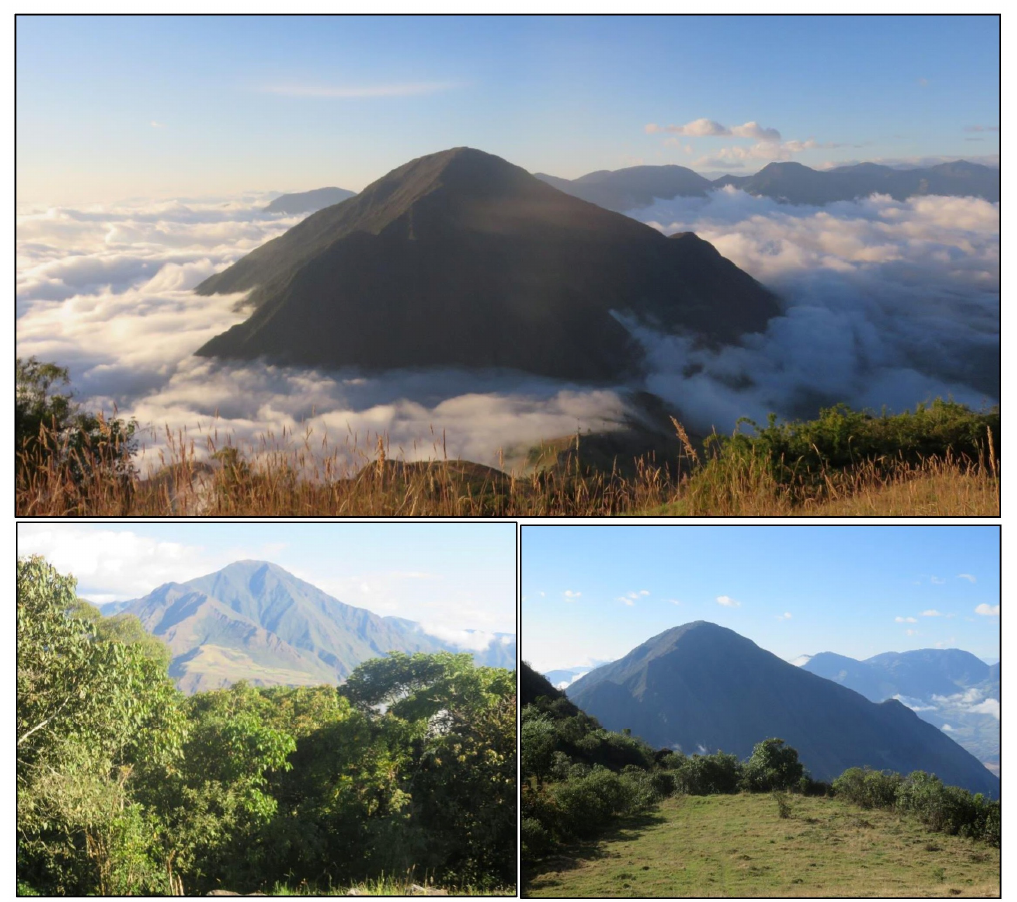
Figure 1. Archeological landscape of the Chanchán basin with the reference to “Mount Puñay” and the montane cloud forest of the western Andean foothills.